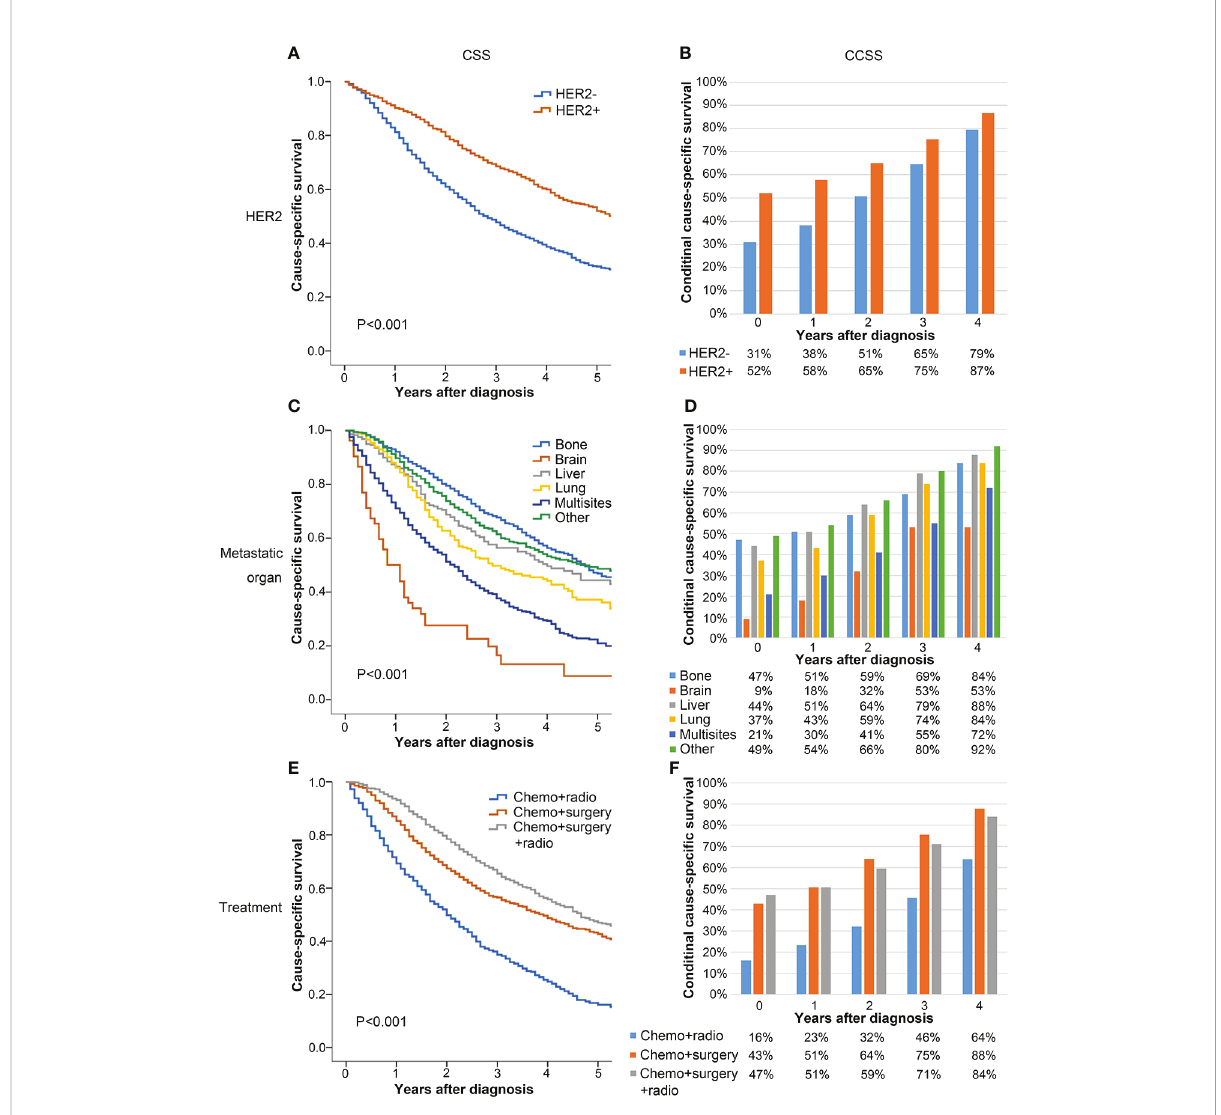
FIGURE 3 Comparison between CSS (A, C, E) and CCSS (B, D, F) according to HER2 (A, B) , metastatic organ (C, D) , and treatment (E,